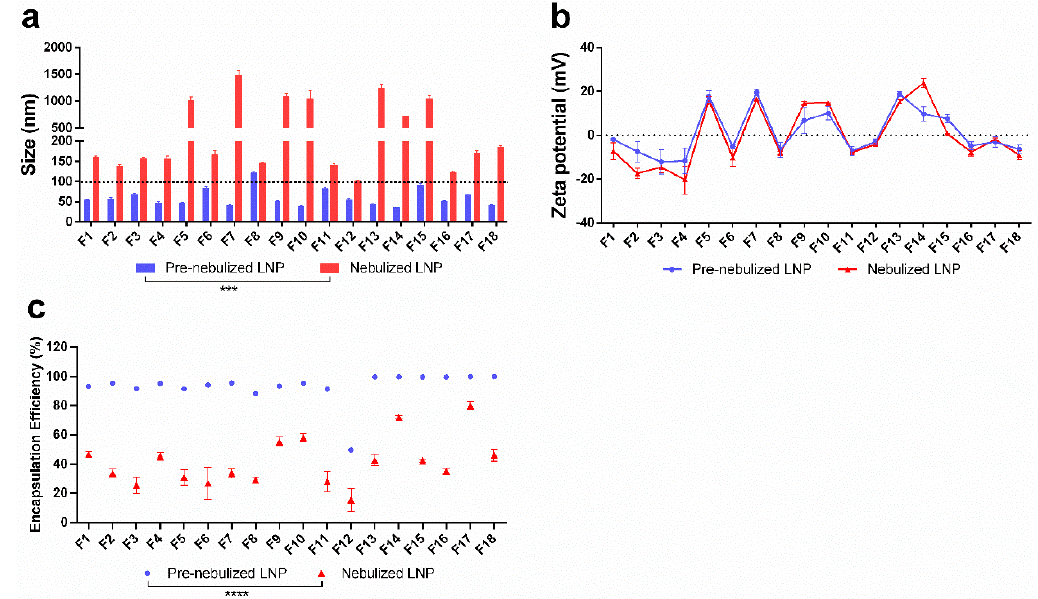
Figure 1. Stability of LNP formulations before and after nebulization in terms of ( a ) size, ( b ) zeta- potential, and ( c ) encapsulation efficiency. The size (*** p = 0.0004) and encapsulation efficiency (**** p < 0.0001) of nebulized formulation were significantly different from pre-nebulized